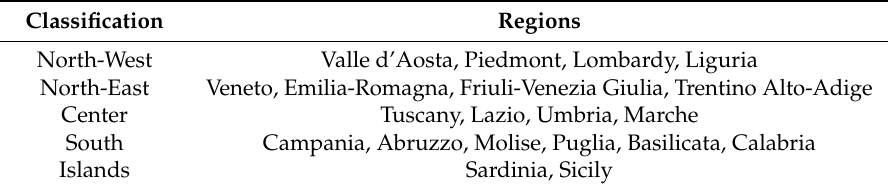
Table 1. Italian regions distributed over the five